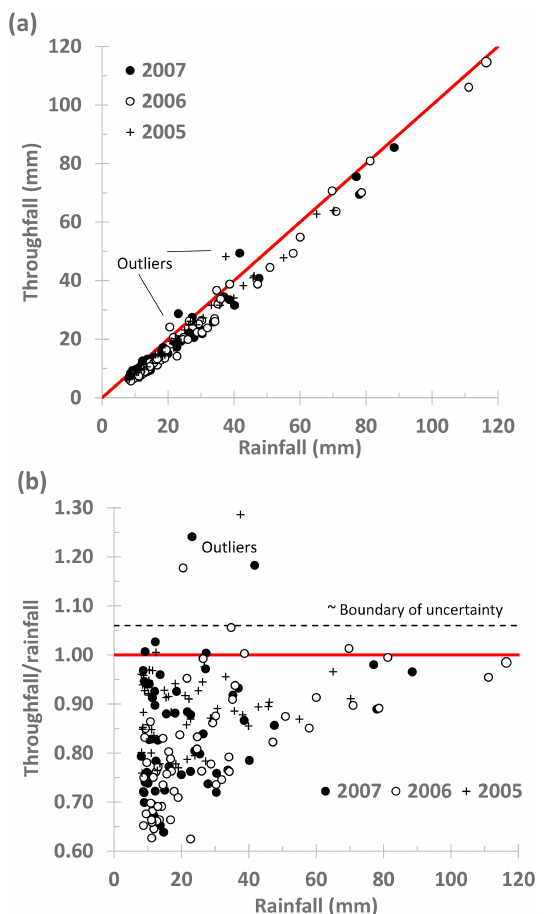
Figure 4. (a) Comparison of throughfall to runoff depths for the 3 years of study (2005–2007). (b) Throughfall fraction of rain- fall for events ranging in depth from 8 to 116mm during the 3- year study. Uncertainty of any throughfall measurement is esti- mated to be ± 6% (indicated in the figure for the case of through- fall = rainfall). The four values labeled “outliers” are exceptionally high estimates of throughfall for which we cannot completely ex- plain the possible